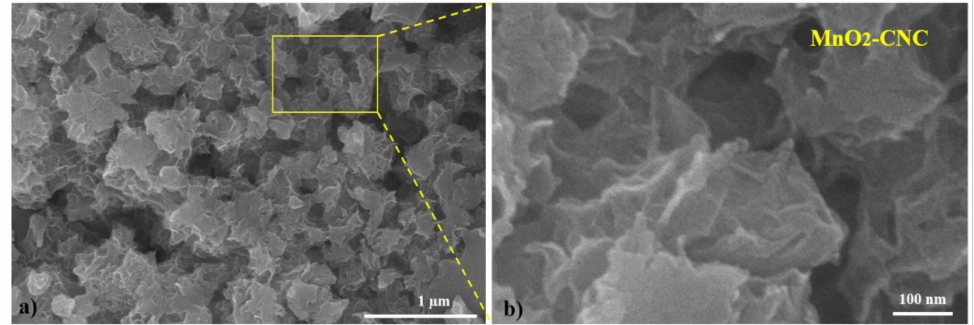
Figure 5. ( a ) Typical and ( b ) high-magnification SEM images of the MnO 2 -CNC